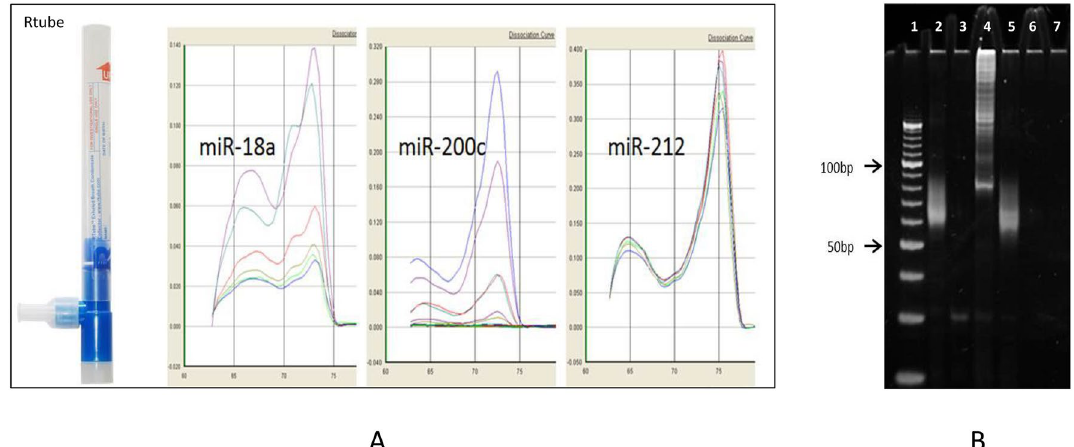
Figure 1. Schematic of EBC-microRNA detection and verification: ( A , left panels) Exhaled microRNA collection and amplification. The method used the handheld disposable Rtube, typical examples of URT- PCR melt curves for miRs 18a, 200c, 212 are shown. ( B , right gel panel): Specificity testing of designed microRNA PCR primers. PCR products were loaded in EtBr gel. Note that 40 bp URTtag + 22 bp microRNA template = 62 bp PCR product. Lane 1: 10 bp DNA ladder; lane 2: cDNA of cultured lung cell microRNA and mRNA (total RNA extract), with both polyadenylation and RT steps; lane 3: No RT step, total RNA from cultured lung cells; lane 4: cDNA of mRNA (no poly-adenylation step, total RNA from cultured lung cells); lane 5: cDNA of EBC microRNA and mRNA (all steps included); lane 6: Genomic DNA spike-in as only template; lane 7: Water blank/no template control. For a microRNA-specific PCR primer set, microRNA-size PCR bands are uniquely seen in lane 2 (cultured lung cell mix RNA extract template, all polyadenylation and RT steps included), and lane 5 (EBC RNA extract template, all polyadenylation and RT steps included). PCR product size is ~ 60–63, reflecting the 20–23 bp microRNA template, and the 40 bp URT tag integrated at the RT step 21–23